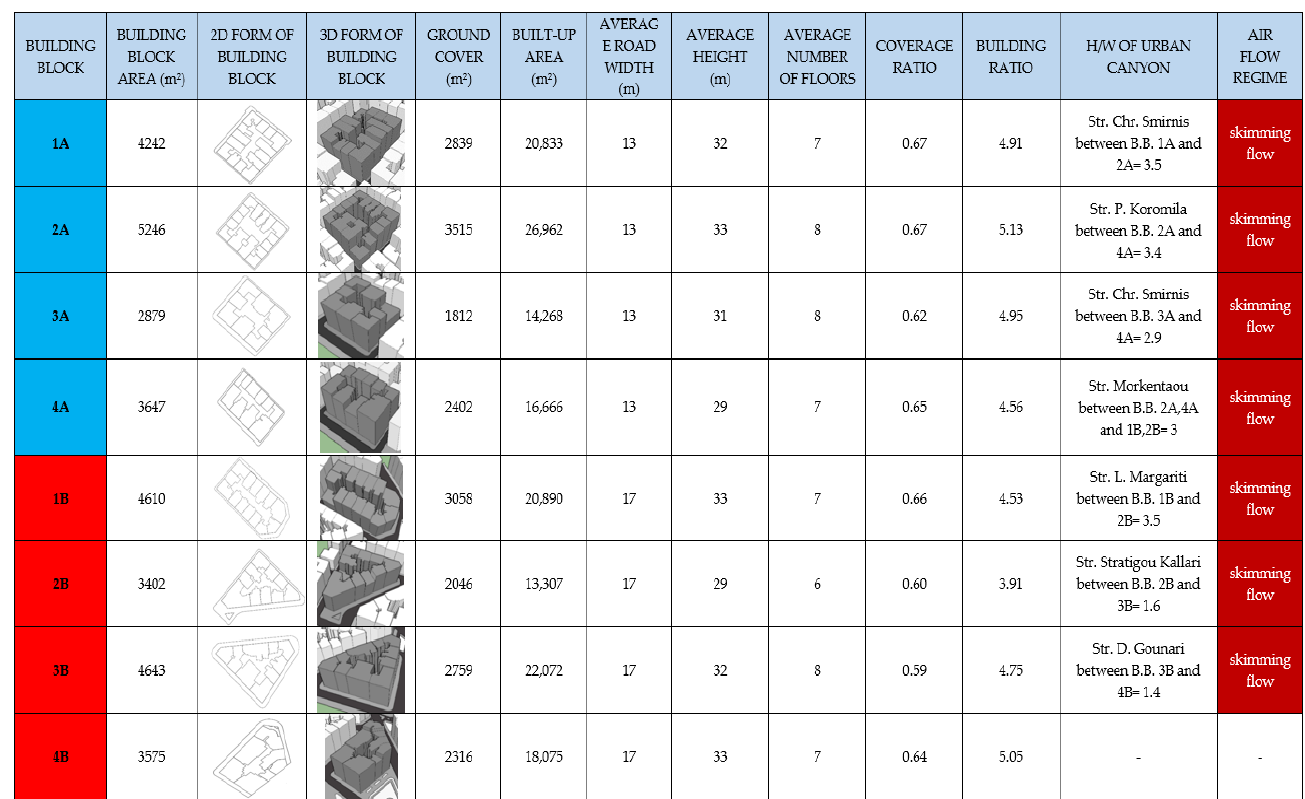
Figure 6. Numbering of building blocks of the study area, ArcGIS software.